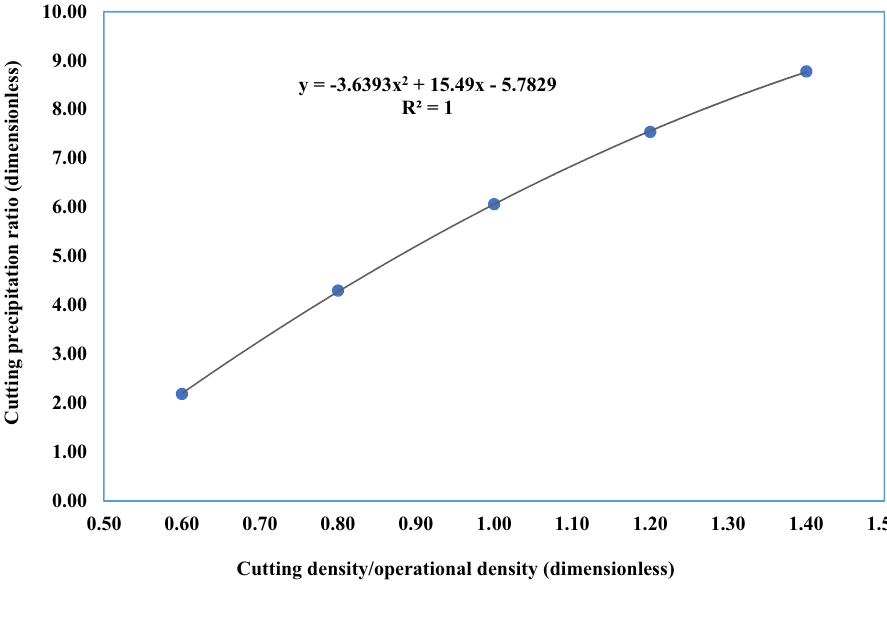
Fig. 21 Stress applied on the drill string versus cutting